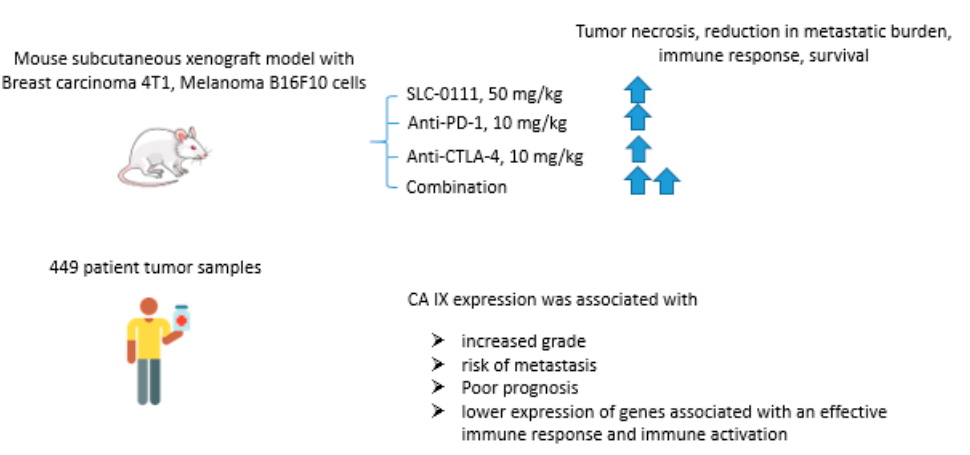
Figure 17. Graphical outline of the study on the combination of SLC-0111+anti-PD-1/anti-CTLA-4 immune checkpoint inhibitors reported by Chafe et al.